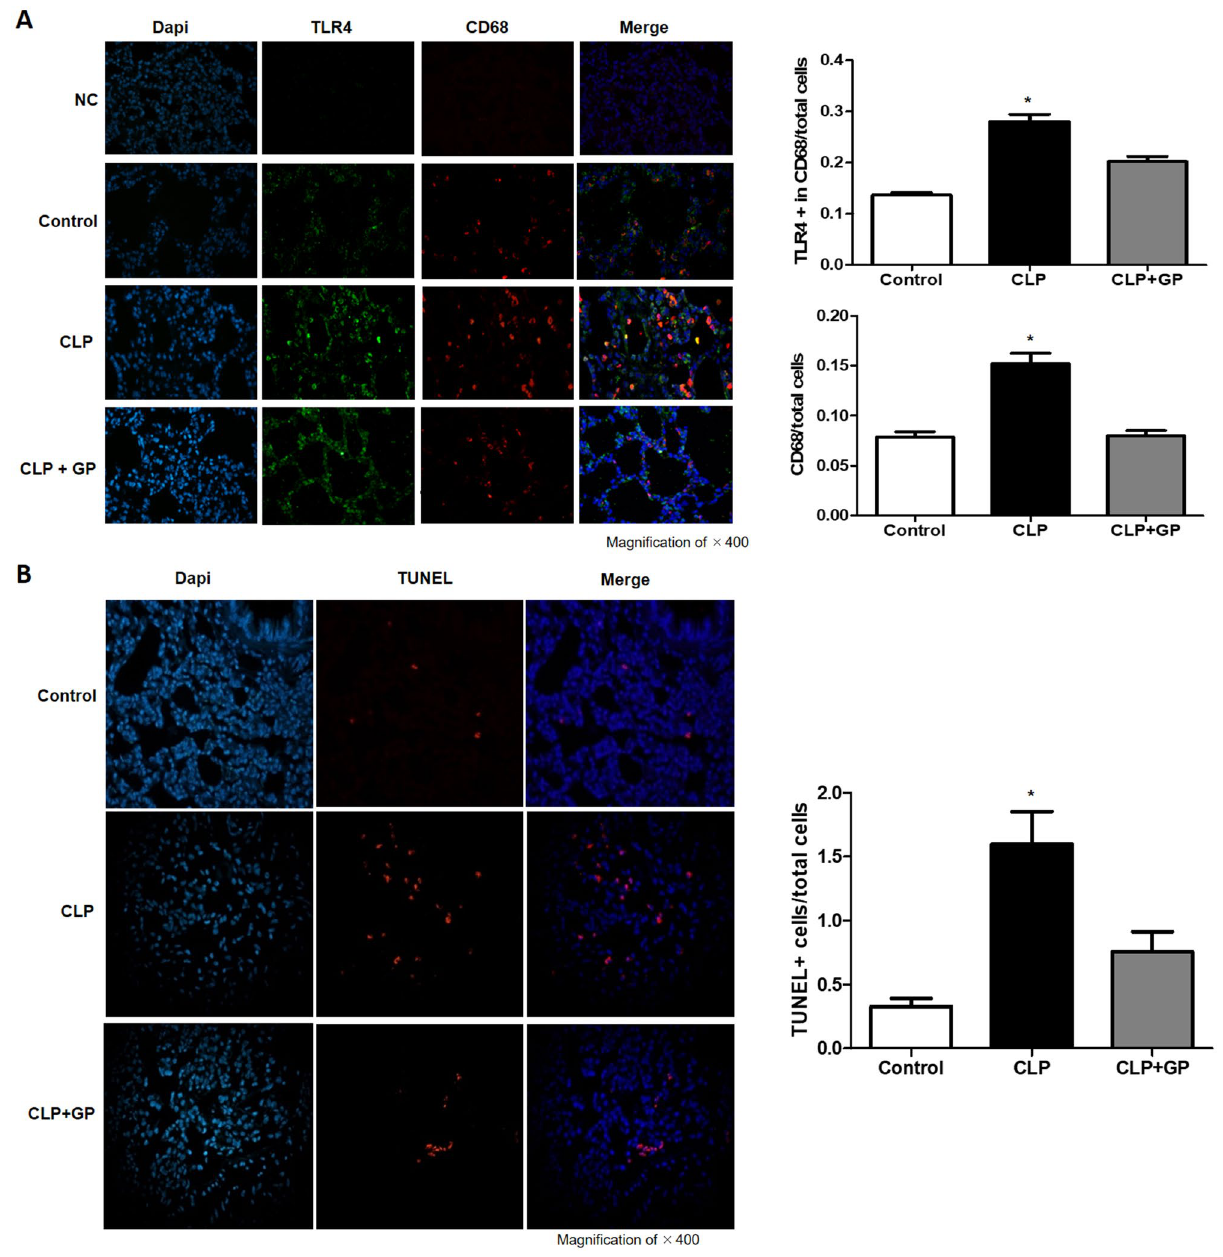
Figure 7. Effects of green propolis on Toll-like receptor 4 (TLR4) protein expression, macrophage infiltration, and apoptosis in lung tissue in control, cecal ligation and puncture (CLP), and CLP + green propolis (CLP + GP) group rats 24 h after the CLP or sham procedure. ( A ) TLR4 expression in macrophage cells. A double-labeling technique was used for CD68 and TLR4 analyzed by immunofluorescence; ( B ) Terminal deoxynucleotidyl transferase-mediated deoxyuridine triphosphate nick-end labeling (TUNEL) + cells analyzed by immunofluorescence. * p < 0.05 versus control and CLP + human gingival fibroblasts. Their results indicated that CAPE inhibits the production of LPS-induced IL-6, IL-8, inducible nitric oxide synthase, and cyclooxygenase 2, in a dose-dependent manner. Those authors also found that CAPE suppresses LPS-induced activation of TLR4/myeloid differentiation factor 88 and NF-κB. Bueno- Silva et al. 41 studied the effect of Brazilian red propolis added to cells of the RAW 264.7 murine macrophage-like cell line after activation with LPS. The authors found that red propolis upregulated CD80 and CD86, whereas it downregulated mannose receptor C type 1, indicating M1 polarization. They also found that it attenuated the production of the pro-inflammatory mediators IL-12, granulocyte–macrophage colony-stimulating factor, IFN-γ, and IL-1β in cell supernatants, as well as significantly reducing the LPS-induced upregulation of tran- scription factors involved in inflammatory signaling (Pdk1, Pak1, Nfkb1, Mtcp1, Gsk3b, Fos, and Elk1). The same authors also showed that the upstream myeloid differentiation factor 88 adaptor-like, which is involved in